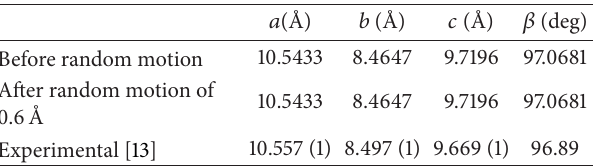
Fe V . 3 27.4 1.6